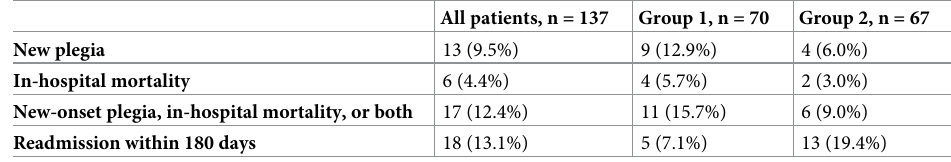
Table 3. Readmission, in-hospital mortality and new plegia by assigned patient groups among patients with SEA, 2015–2019. All patients, n = 137 Group 1, n = 70 Group 2, n = 67 New plegia 13 (9.5%) 9 (12.9%) 4 (6.0%) In-hospital mortality 6 (4.4%) New-onset plegia, in-hospital mortality, or both 17